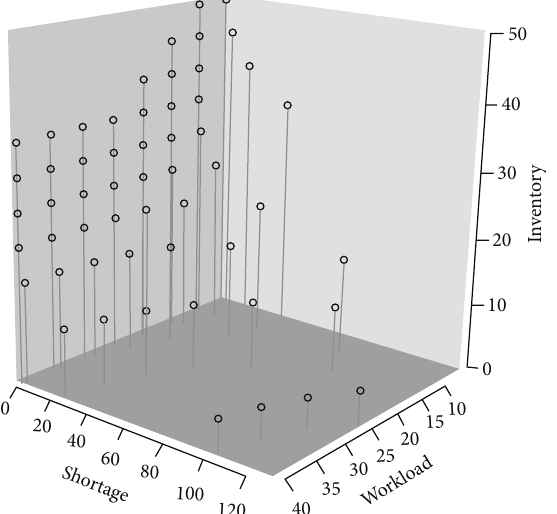
Figure 4: Scatterplot of Item 2 nondominated solutions from successive approximation.